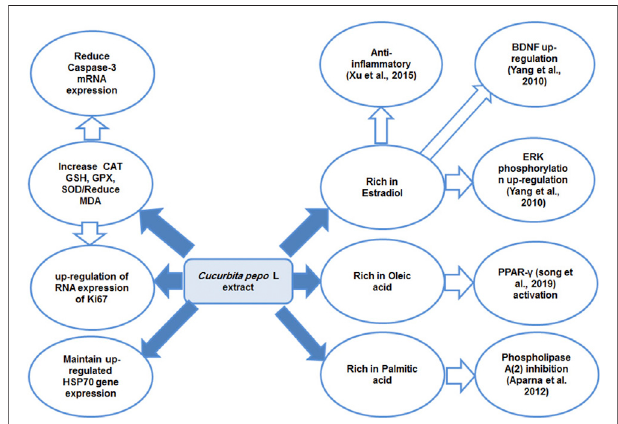
FIGURE 7 | Diagram summarizing the proposed mechanism of antidepressant effect of the Cucurbita pepo L extract. Peroxisome proliferator – activated receptor gamma (PPAR- γ ), extracellular signal – regulated kinase (ERK), brain-derived neurotropic factor (BDNF), catalase(CAT),glutathioneperoxidase(GPX),reducedglutathione(GSH),and superoxide dismutase heat shock protein